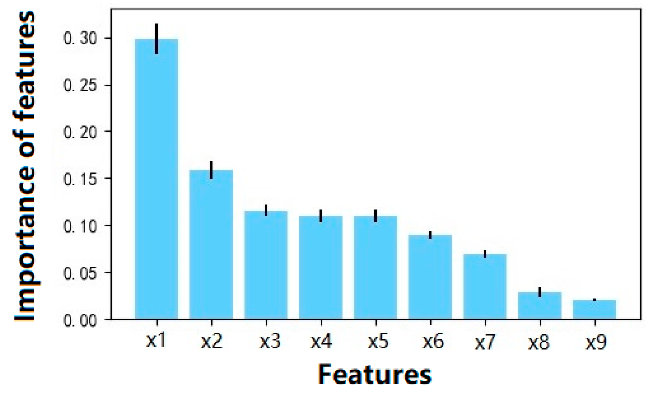
Figure 9. Importance of input characteristic of charging stations.